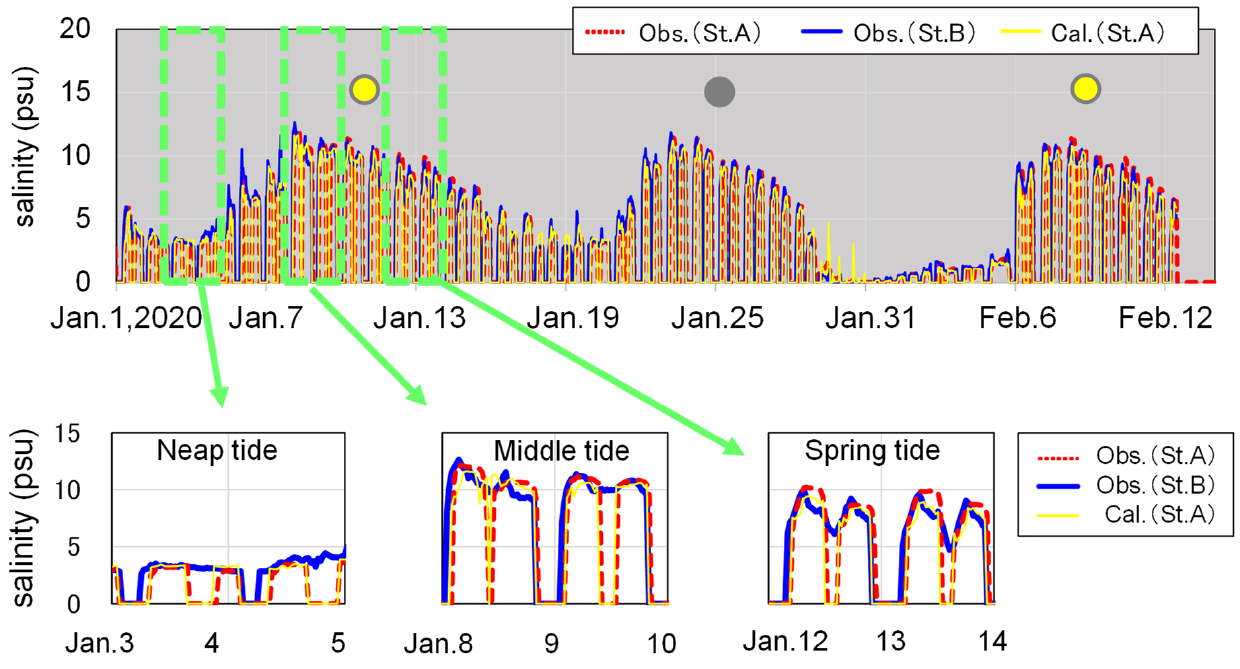
Figure 9. Time series of salinity at St. A and St. B.